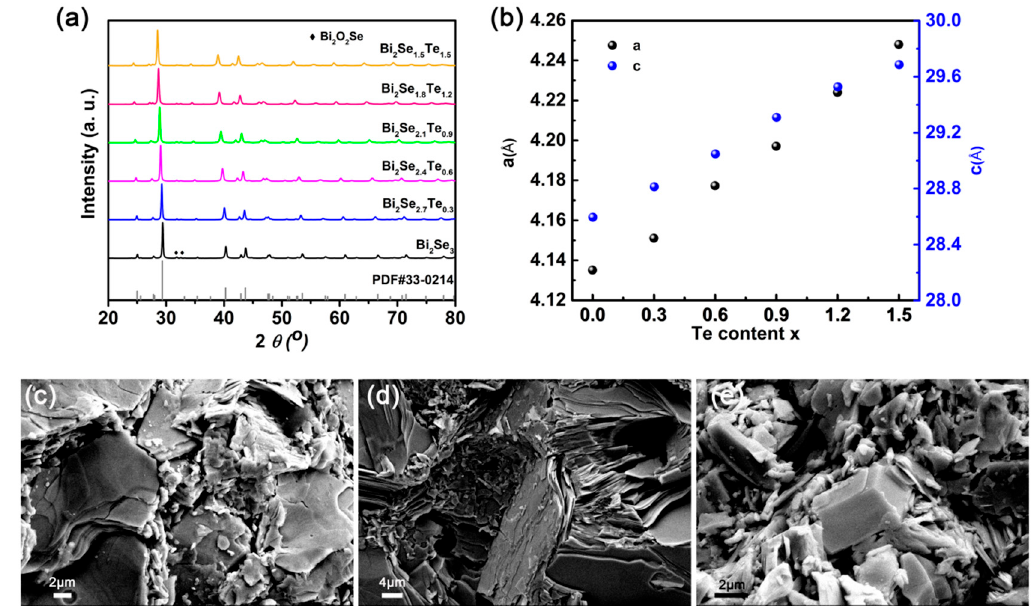
Figure 1. ( a ) XRD patterns and ( b ) lattice parameters of sintered Bi 2 Se 3 − x Te x bulk samples; field-emission scanning electron micrographs of Bi 2 Se 3 − x Te x , for which, ( c ) x = 0; ( d ) x = 0.3; and ( e ) x = 1.5.